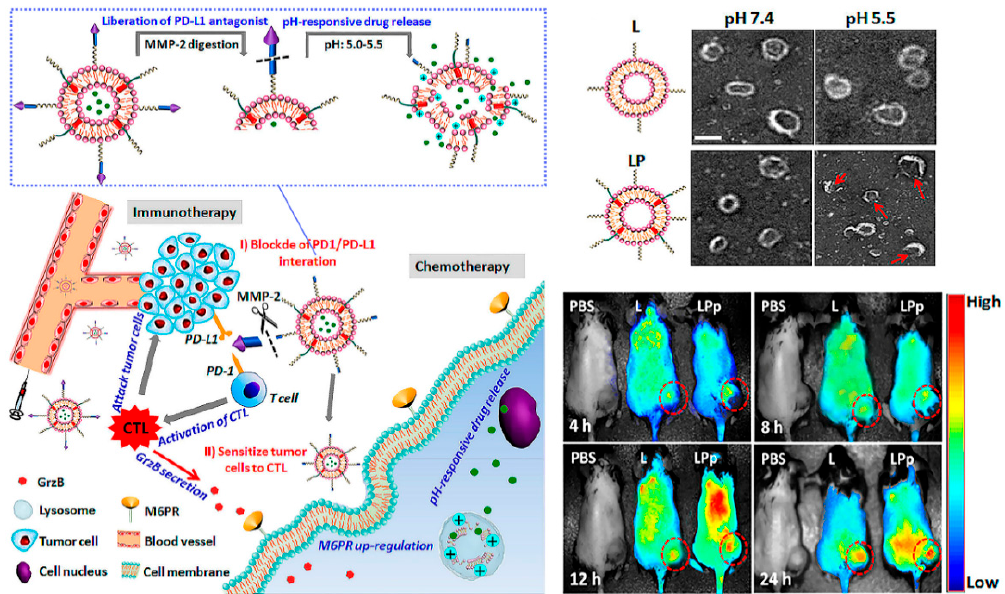
Figure 3. Combination immunotherapy with immune checkpoint blockade. pH and enzyme dual-responsive polymer–liposomes (LPDp) grafted with anti-PD-L1 peptide and encapsulating low-dose doxorubicin (DOX) for combination of cancer immunotherapy and chemotherapy. As shown in theTEMimages of L or LP with 2 mol % of pH-responsive polymer in PBS buffer solution, under the weakly acidic conditions of the tumor microenvironment, LP can respond to smaller nanospheres in order to avoid clearance by the immune system. And in vivo imaging has been proven it enriched at the tumor site with higher intensity. Reproduced from Reference [32] with permission. Copyright: 2019 American Chemical Society.